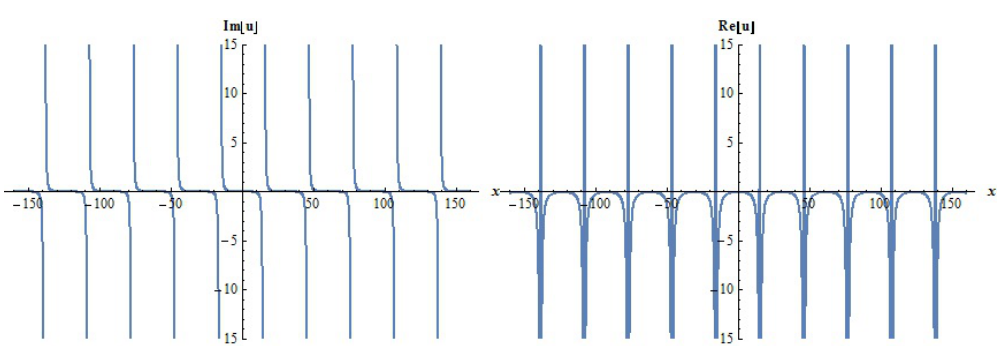
Figure 5. The 2D graphs of u 5 for α 2 = 0.1, α 3 = 0.32, ε = 1, w = 0.012, A 2 = 0.2, c = 0.3, t = 0.13, y = 0.05.